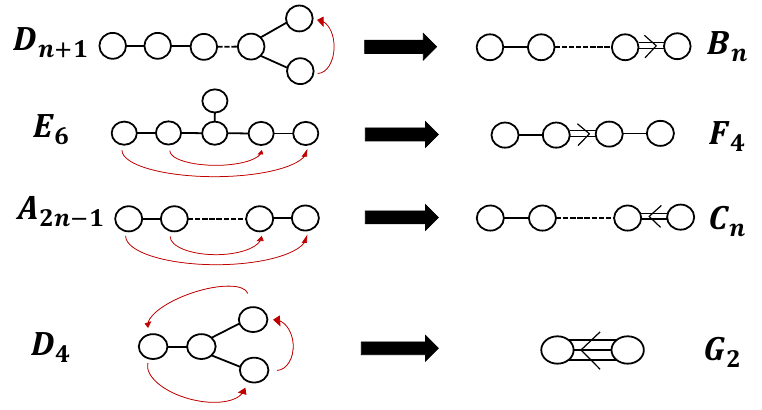
Figure 1. The action of the outer automorphism group A on the simply-laced Lie algberas. In